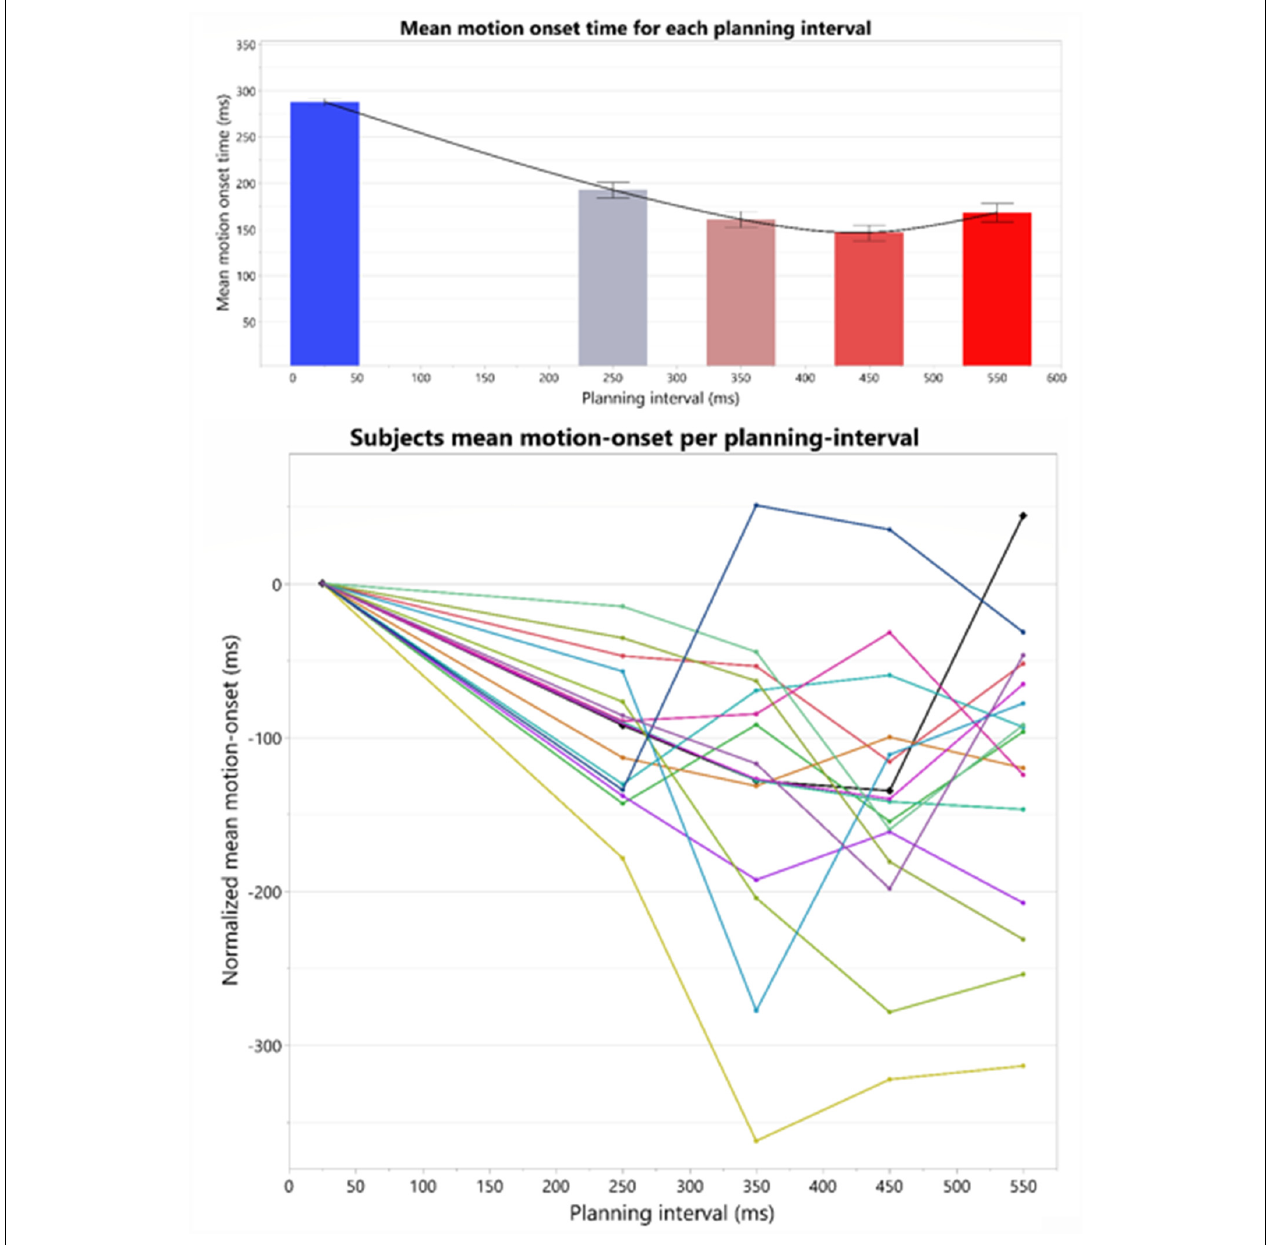
FIGURE 4 | Top: overall U-shape pattern across all the subjects. The bars represent the means and standard-errors of motion-onset response times (RTs) in each motor planning interval condition, where the four right bars are calculated over the Long trial RTs in each of the blocks, and the leftmost bar is calculated over the Short trials RTs across all the blocks. Bottom: individual motion-onset RT for each subject and each planning interval condition, averaged over four targets, and all trials for each target. All graphs were drawn together and aligned to a 0 starting time, to see overall similarities and differences in response pattern.